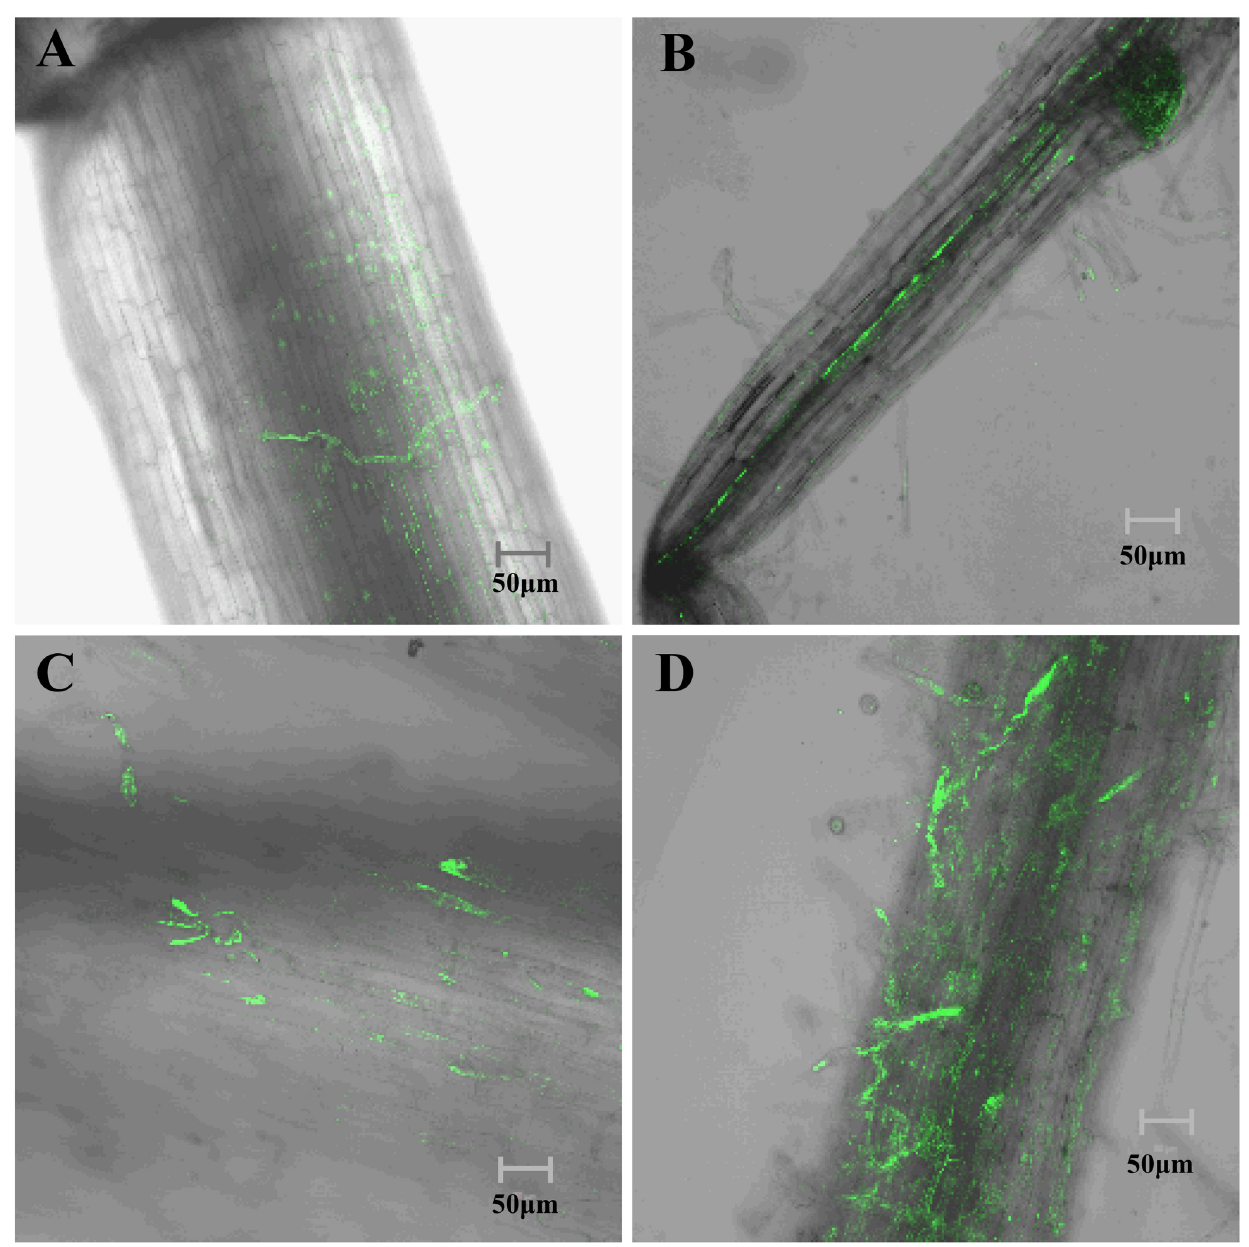
Fig 2. Dynamic changes in the rhizosphere of watermelon infected with M45a-GFP. A, B: Colonization results of the root elongation zone on Days 3 and 7, respectively; C, D: colonization results of the root hair zone on Days 3 and 7,